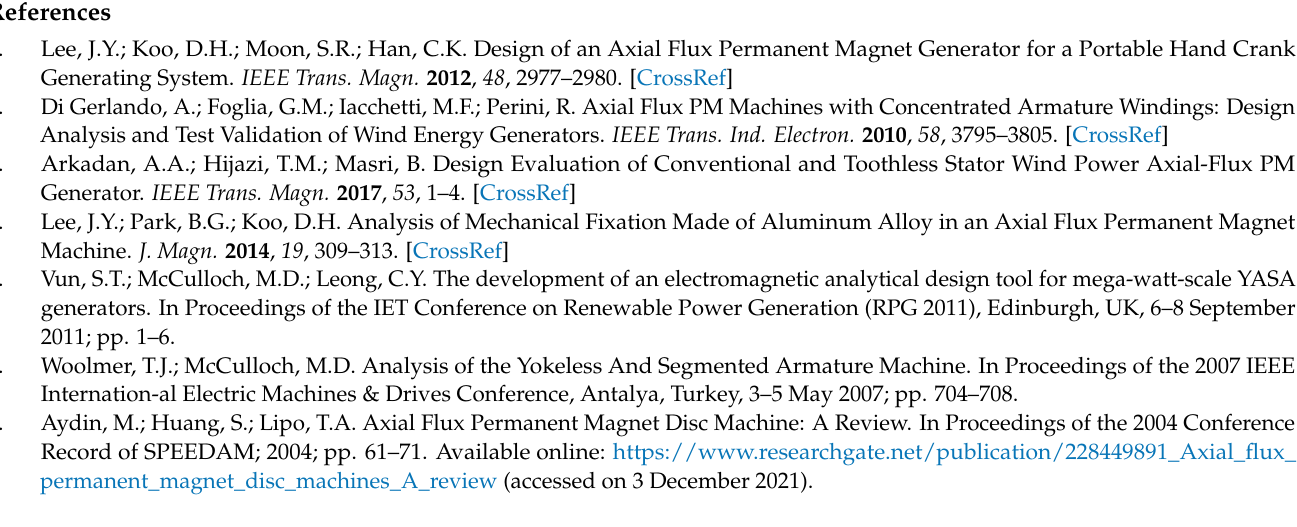
Figure 15. Temperature saturation test (resistive load is 2 ohm).